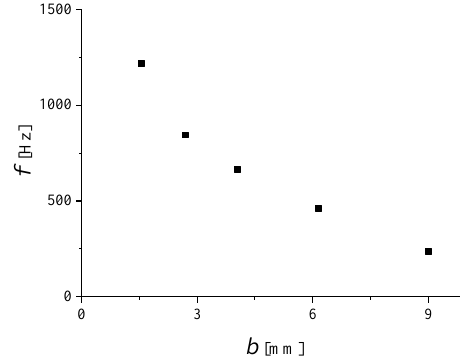
Figure 15. Change in f with various values of b.